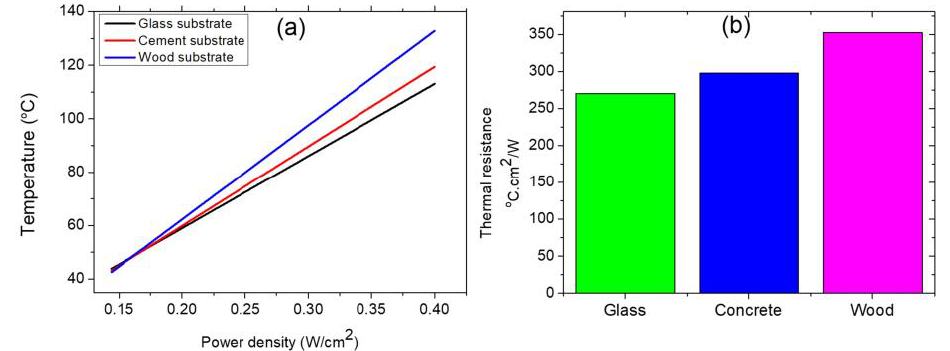
Figure 8. ( a ) Steady temperature versus the input power density for AgNWs/glass, AgNWs/cement, and AgNWs/wood heaters; and ( b ) s comparison between the thermal resistance per unit area of the three heaters. Table 1. Comparison between the current study and the literature for the important parameters of heaters based on AgNWs .